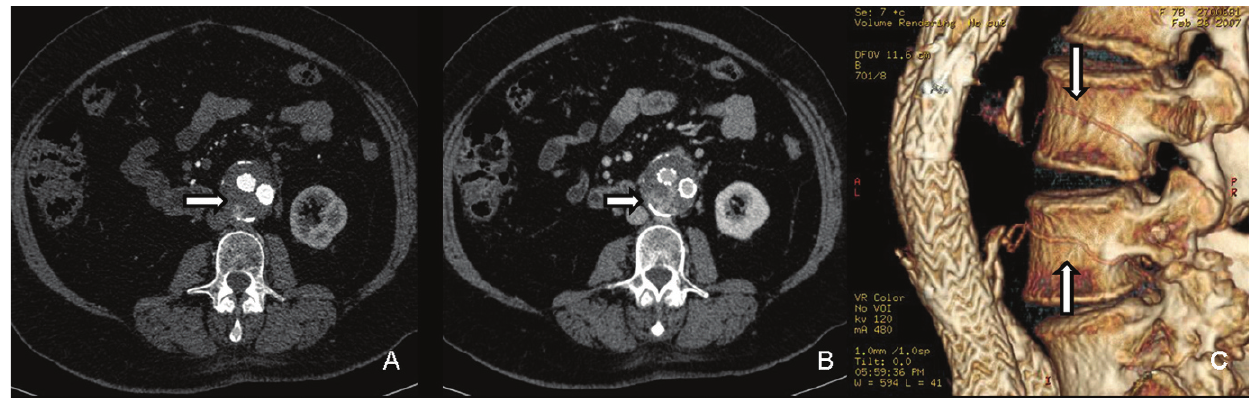
Figure 2 - Type-IIB from the lumbar arteries (arrows) in the arterial (A) and venous (B) phases of the MDCT reveal an increase at the site of contrast during the venous phase. Using the volume-rendering algorithm (C), it is clear that two distinct levels of lumbar arteries are filling the aneurysmal sack